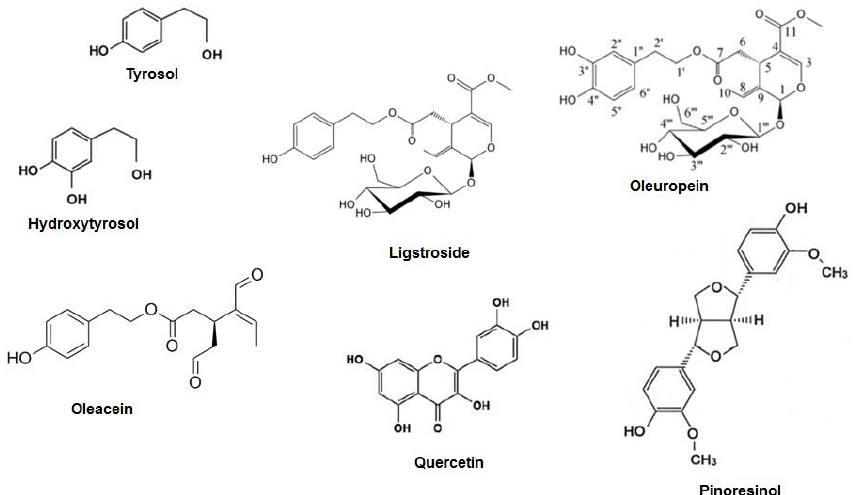
Figure 2. Classification of olive tree biophenols and most representative compounds.